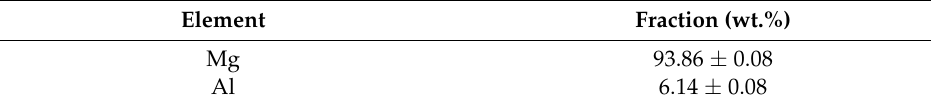
Figure 3. ( a ) SEM micrograph and ( b ) EDS mapping of a rolled Mg-6Al plate. Table 1. The EDS results of the elemental analysis. Element